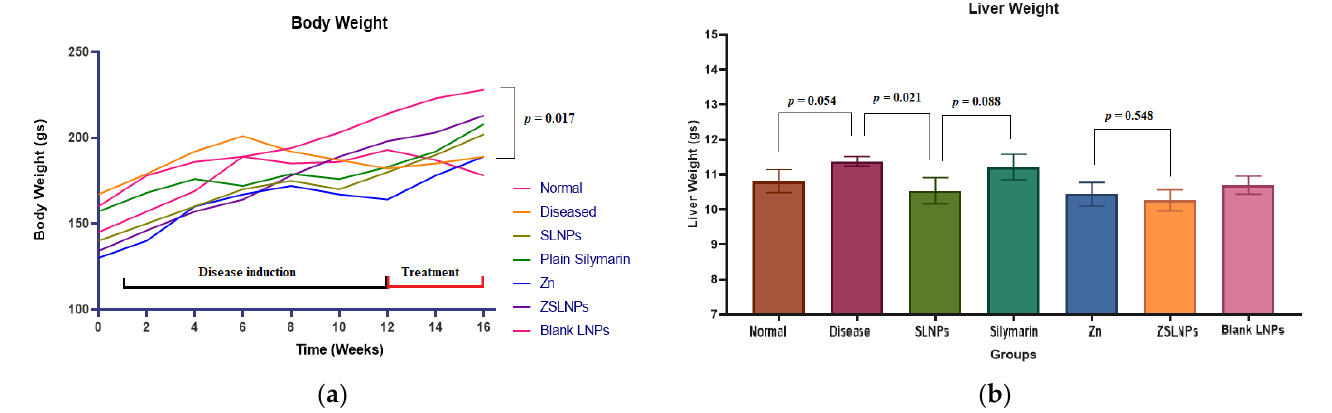
Figure 8. ( a ) Mean body and ( b ) liver weights of rats ( n = 5), with the body weight recorded weekly and liver weights measured after sacrifice using a weight scale, and statistical significance between groups using independent t -test, following the different treatments for a period of 21 days through gavage: diseased, SLNPs (500 µg/kg BW), silymarin (10 mg/kg BW), Zn (10 mg/kg BW), ZSLNPs (10 mg/kg BW + 500 µg/kg BW), and BLNPs (500 µg/kg BW).